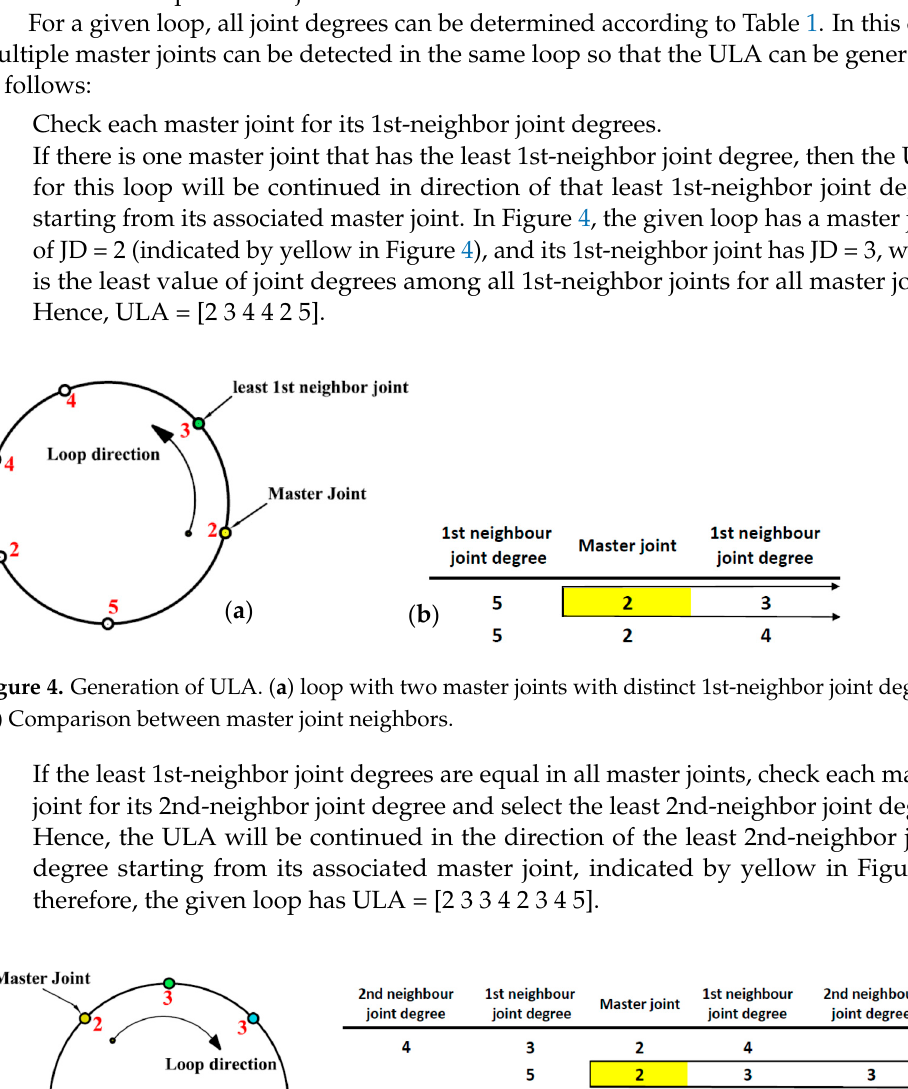
Figure 3. Examples for loops that have a single master joint. ( a ) non equal 1st neighbor joint degrees. ( b ) equal 1st neighbor joint degrees. ( c ) equal 1st and 2nd neighbor joint degrees.